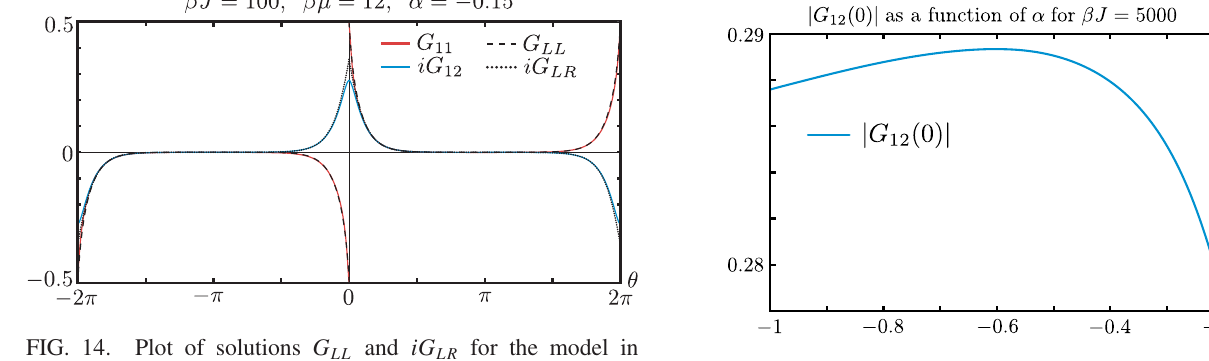
, i.e., j G 12 ð 0 Þj , as a SYK